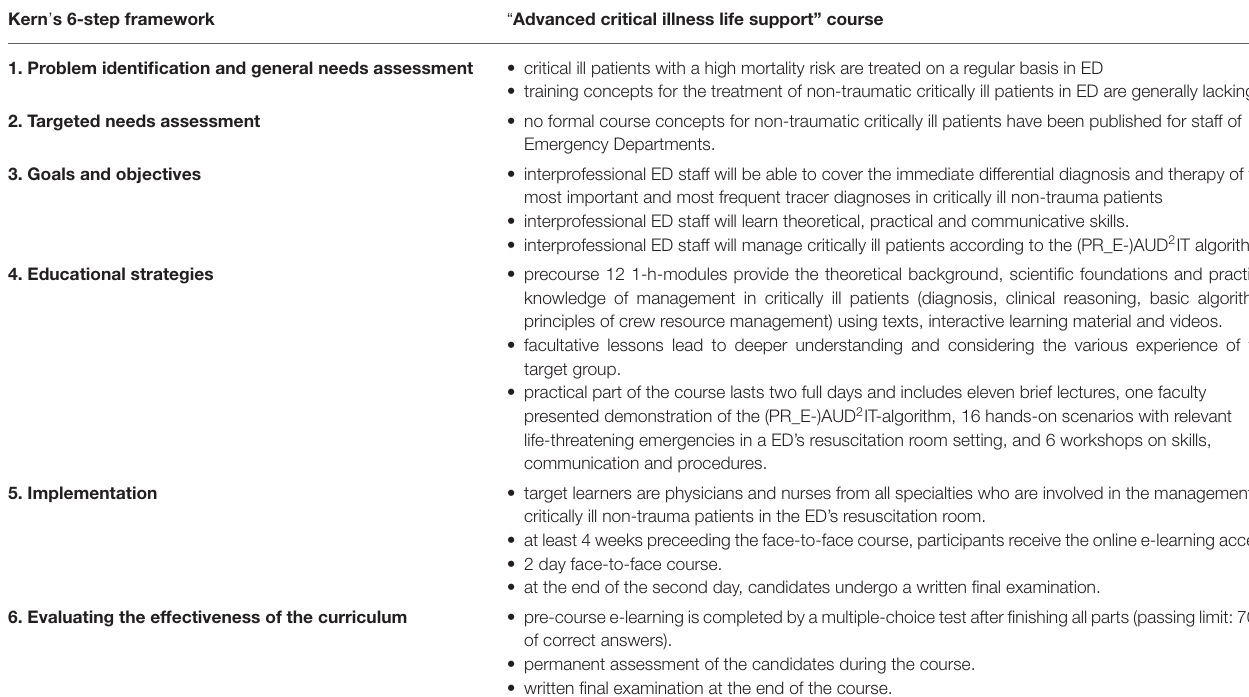
TABLE 1 | “Advanced Critical illness Life Support” course curriculum development using Kern’s 6-step